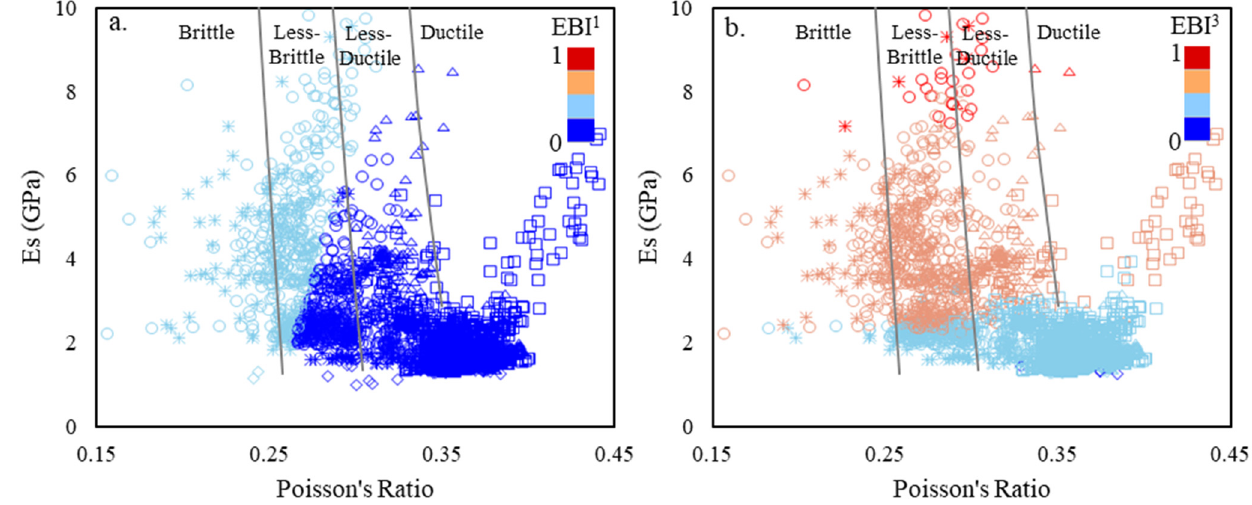
Figure 8. E s versus ν cross-plots of the Upper Jurassic caprock from the North Sea and the Barents Sea color-coded with: ( a ) EBI 1 and ( b ) EBI 3 . The BI boundaries are adapted from Perez and Marfurt [67].